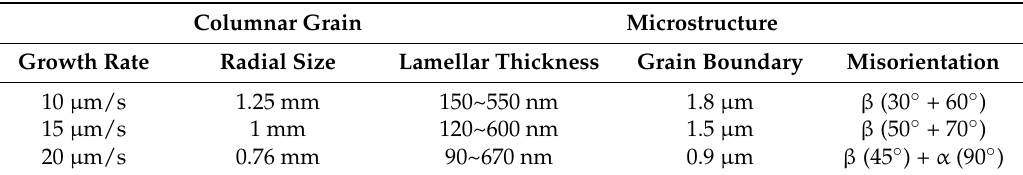
Figure 2. Longitudinal macrostructures ( a – c ) and the corresponding microstructures ( d – i ) in the stable zone of the DS Ti-44Al-9Nb-1Cr-0.2W-0.2Y (at. %) specimen at growth rates of 10 μ m/s, 15 μ m/s and 20 μ m/s, respectively. Table 1. Morphology parameters of the steadily solidified DS alloys.